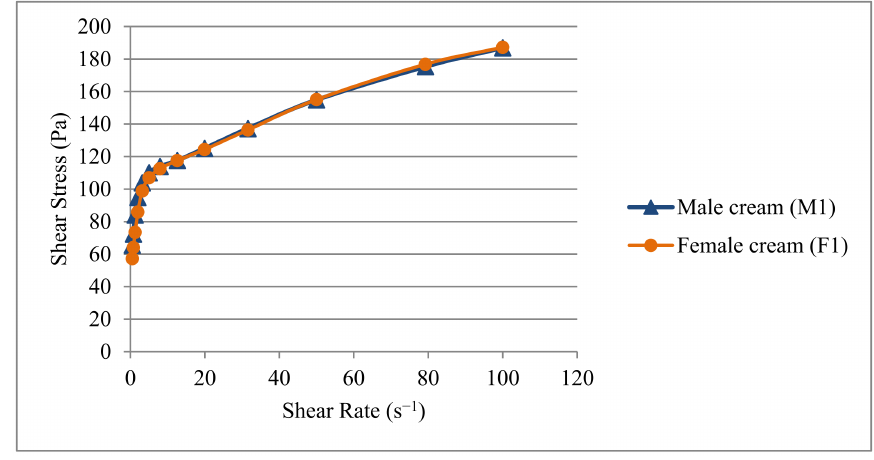
Figure 2. Graph of Shear stress (Pa) vs. Shear rate (s − 1 ).